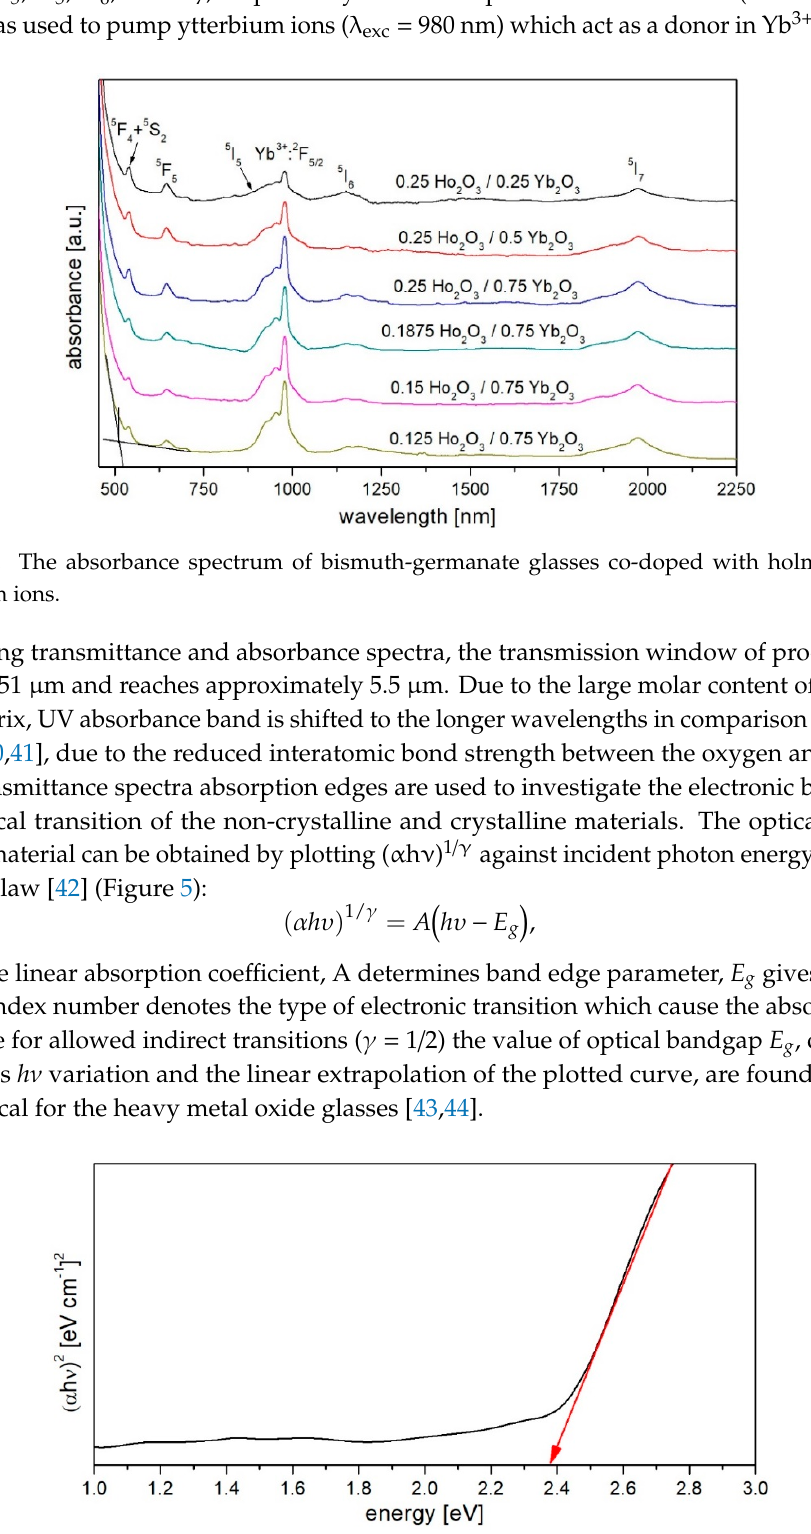
Figure 5. The optical bandgap energy evaluation of ( α h ν ) 2 vs photon energy plot.